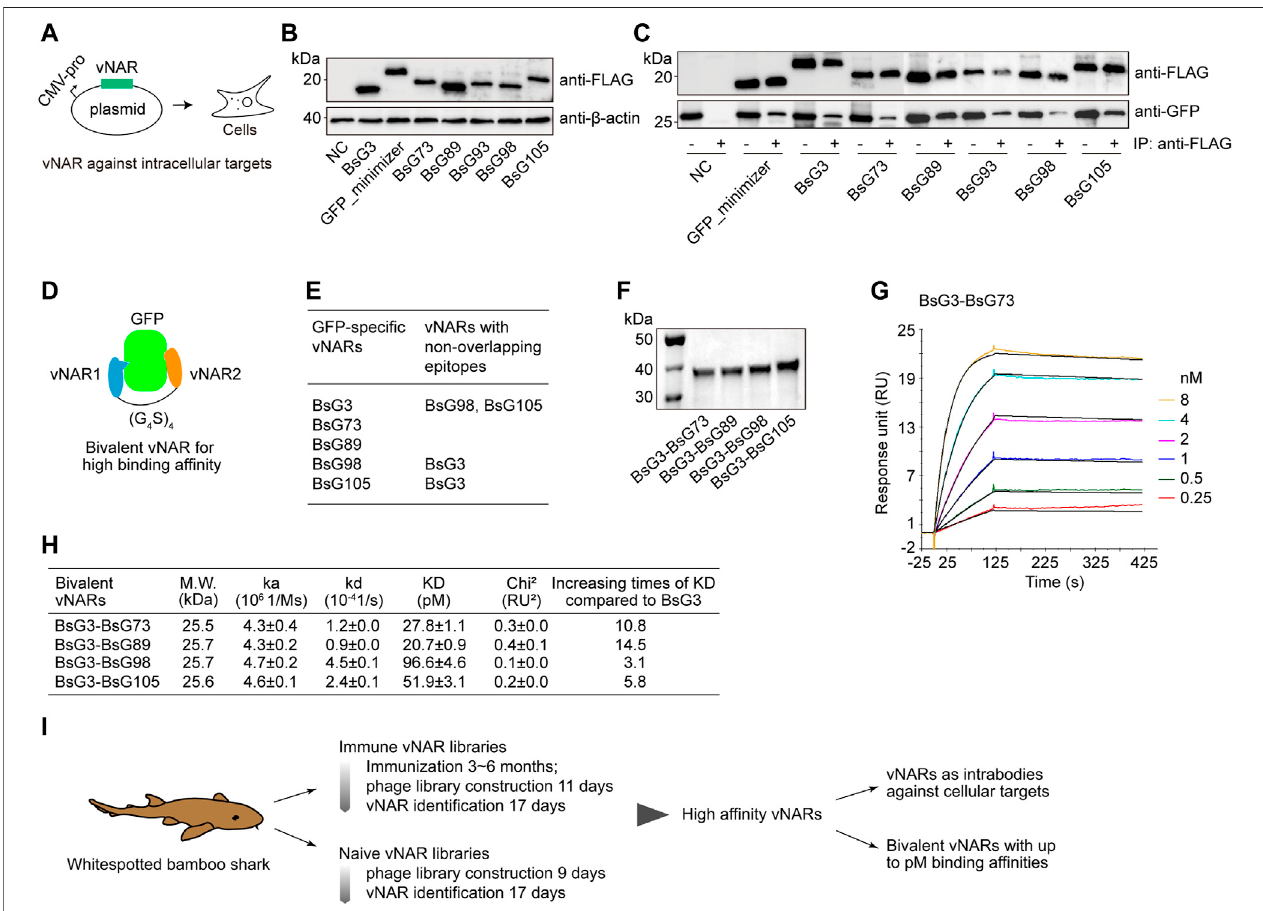
FIGURE 6 | Validation of GFP-speci fi c vNARs as intrabodies and bivalent constructs. (A) Schematic for vNARs as intrabodies in human cells. (B) Expression of vNARs inHEK293T cells. (C) Native GFP-vNAR complexes werepulled down from celllysates. (D) DesignofbivalentvNARs. (E) Mappingofbinding epitopes. (F) SDS- PAGE of puri fi ed bivalent vNARs. (G) SPR sensorgram of BsG3-BsG98 binding with GFP. (H) Binding af fi nities of four bivalent vNARs to GFP. The values represent mean ± standard error. (I) Schematic for the identi fi cation of high-af fi nity binders from bamboo shark vNAR library and their applications.